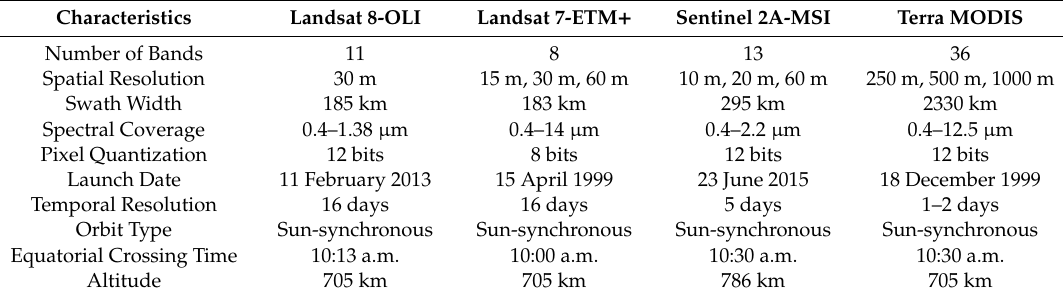
Table 1. Basic Sensor Characteristics